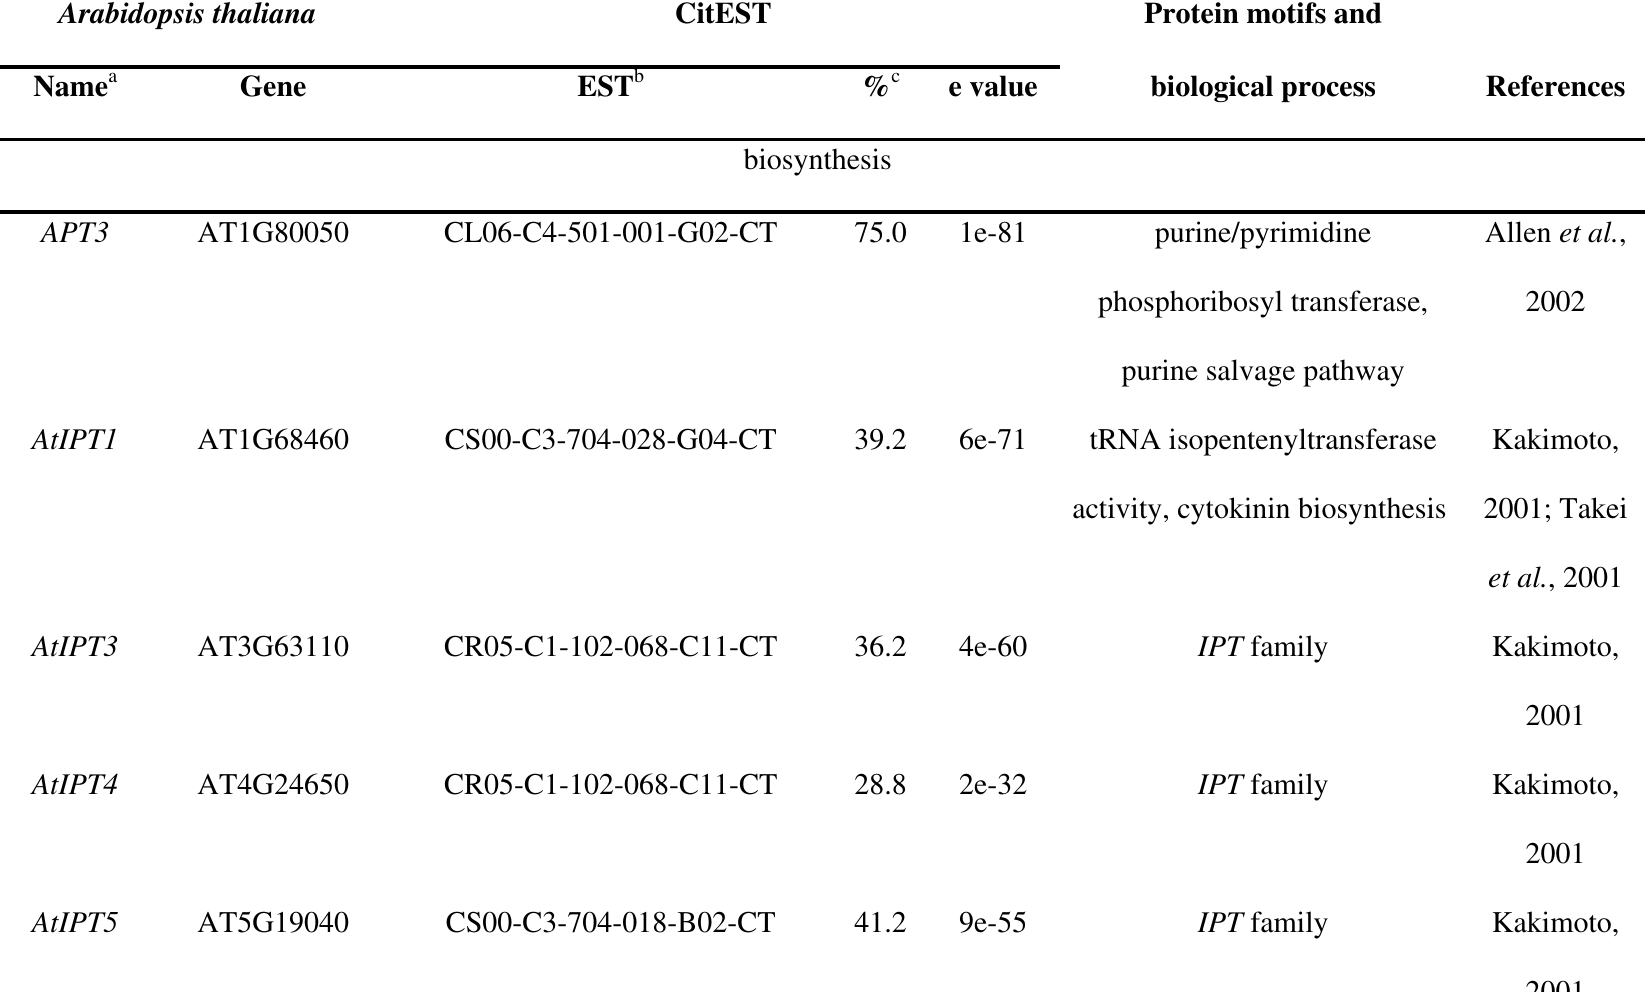
Table S6 – Citrus ESTs with homology to genes involved in cytokinin metabolism and transport in Arabidopsis thaliana